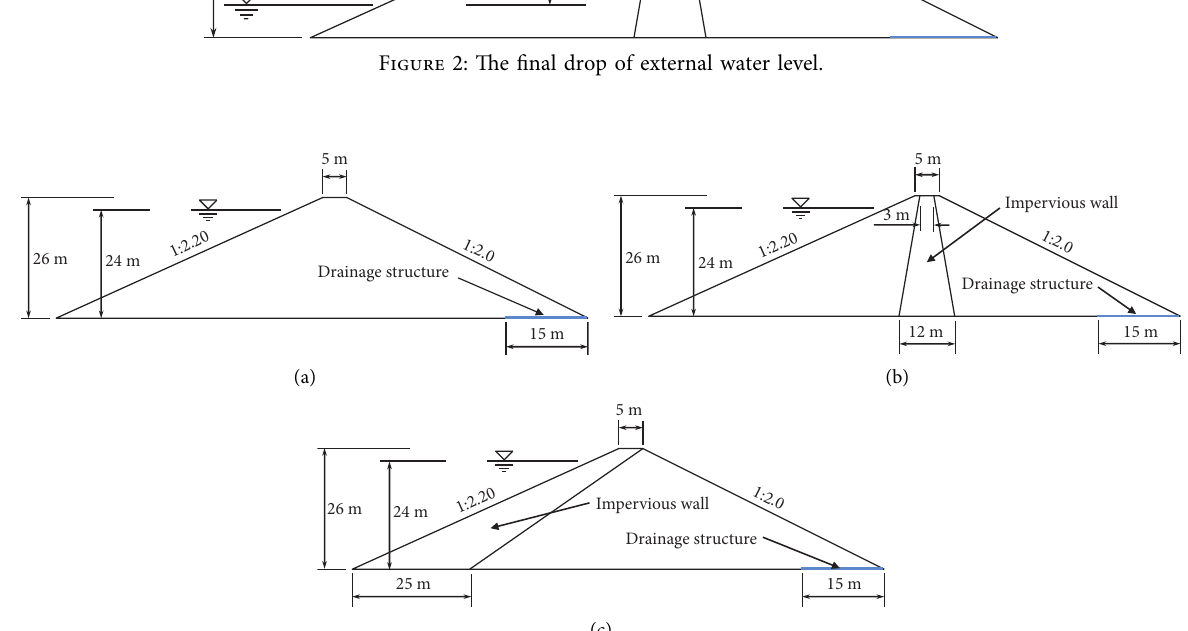
Figure 3: The schematic cross sections in the case of the same slope gradients: (a) homogeneous dam, (b) CCD, and (c) SUCD.